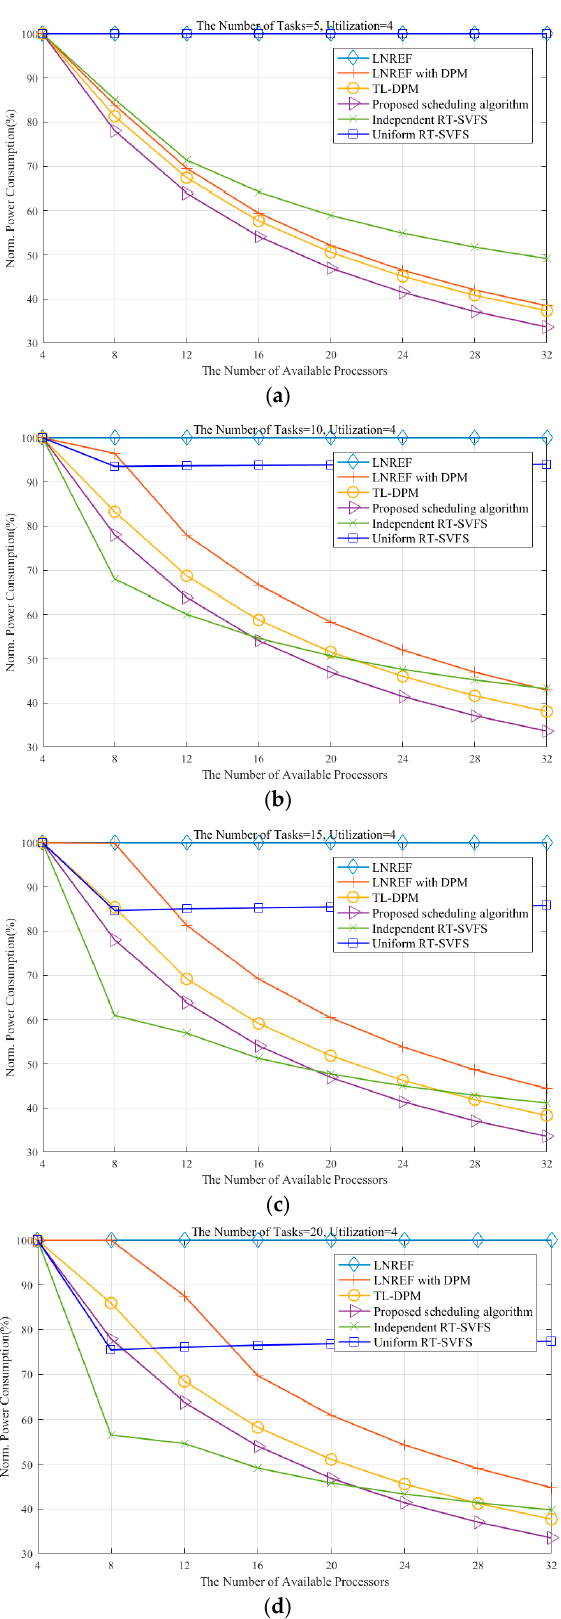
Figure 6. Comparison of energy-efficient approaches for T-L plane abstraction. The number of tasks is ( a ) 5, ( b ) 10, ( c ) 15, and ( d ) 20.